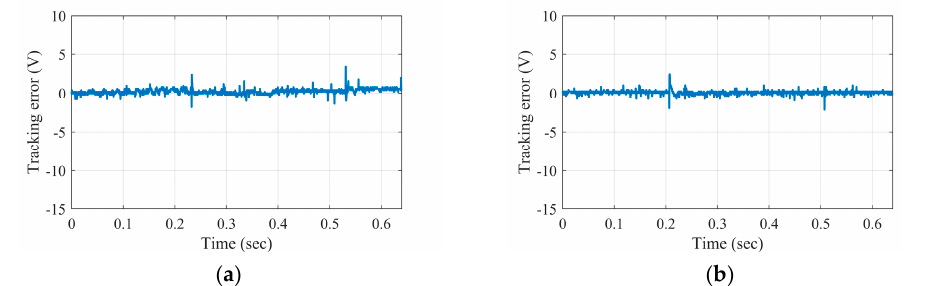
Figure 10. Tracking performance in Case 2 with DC motor load, ( a ) PI control, and ( b ) FTSM-ELM control.